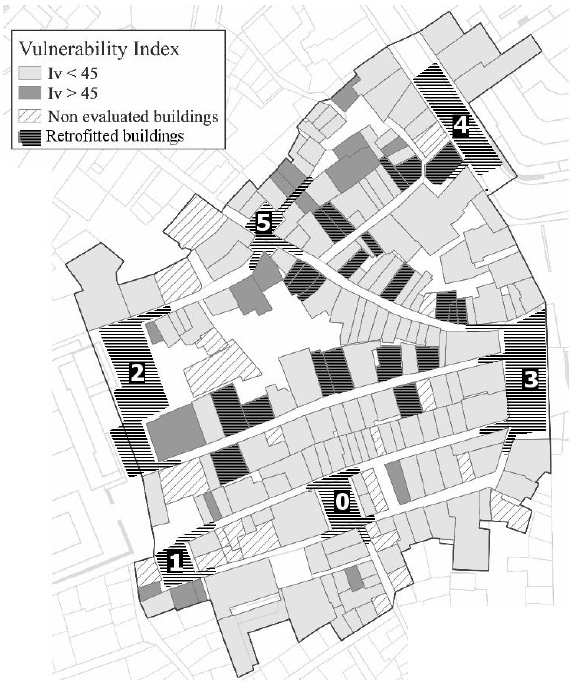
Figure 5. Urban layout involved in SCENARIO C, by outlining the position of assembly areas (and related access) defined according to SCENARIO B (dashed areas) and the retrofitted buildings.